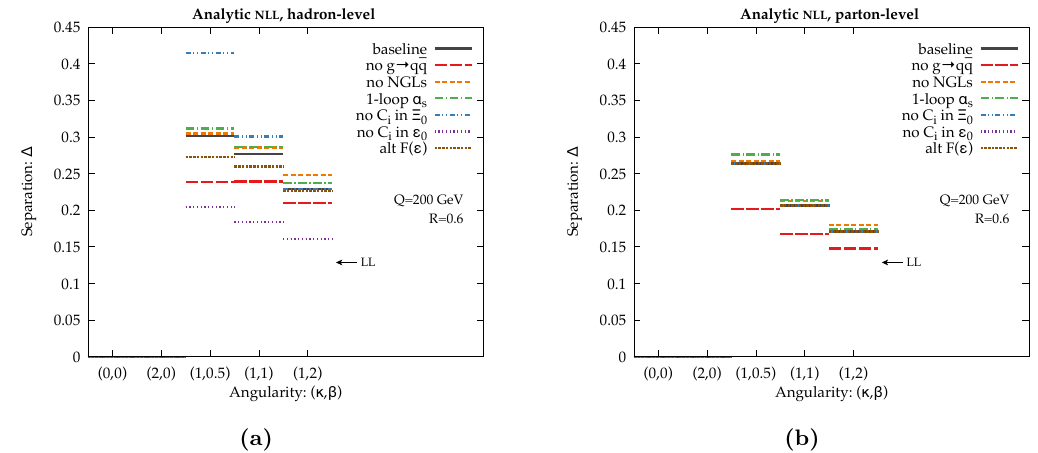
Figure 15. Same as (cid:12)gure 9, but for the analytic NLL calculation from section